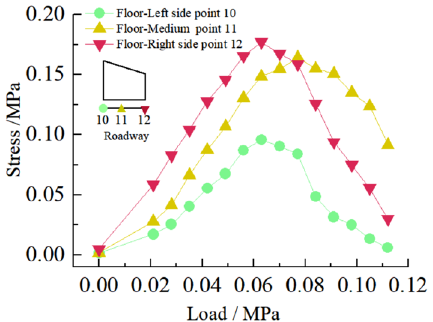
Figure 17. Curve of roadway floor stress with load.